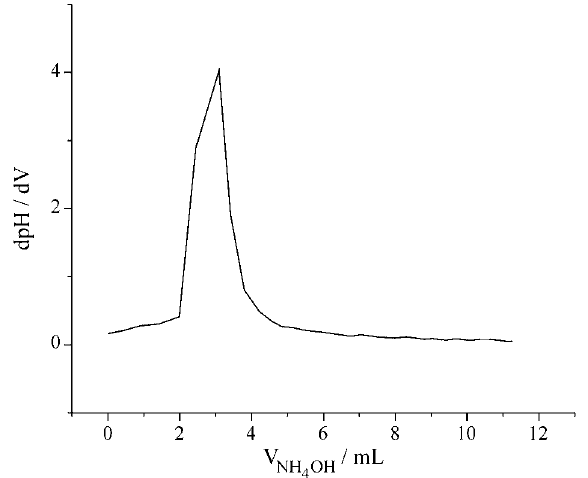
Figure 1a. Curvas potenciométrica y conductimétrica para una disolu- ción 0.02 molar de Al 2 (SO 4 ) 3